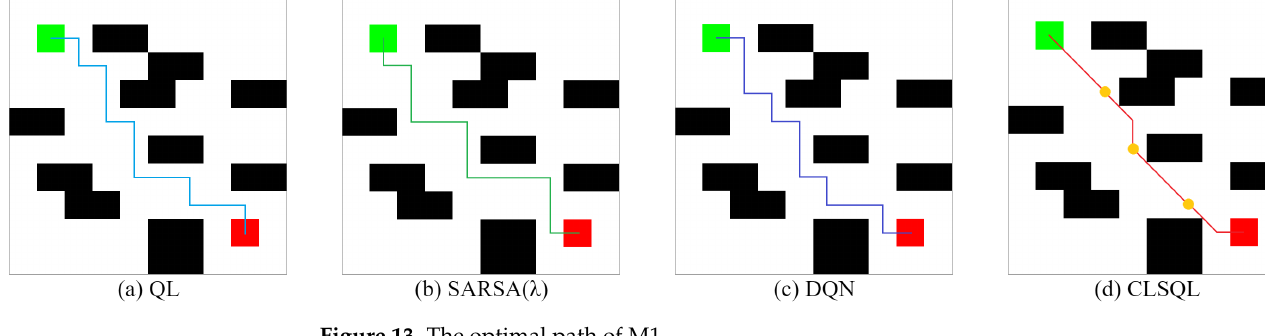
Figure 13. The optimal path of M1.